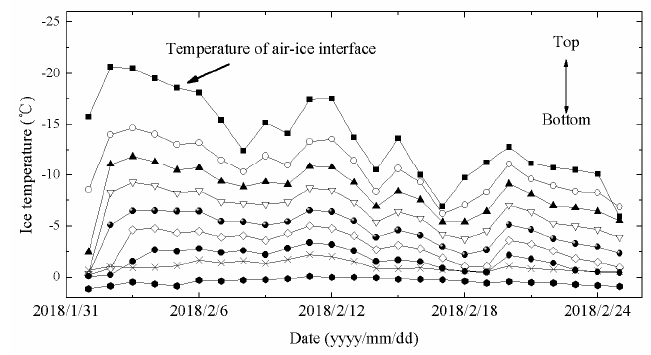
Figure 15. Ice temperature measured by TYUT thermistor string from 1 February to 25 February.